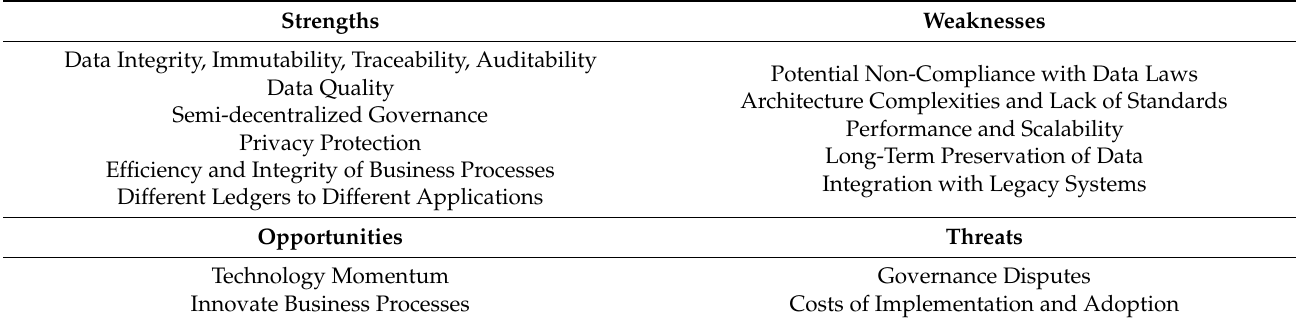
Table 2. SWOT analysis of proposed AD